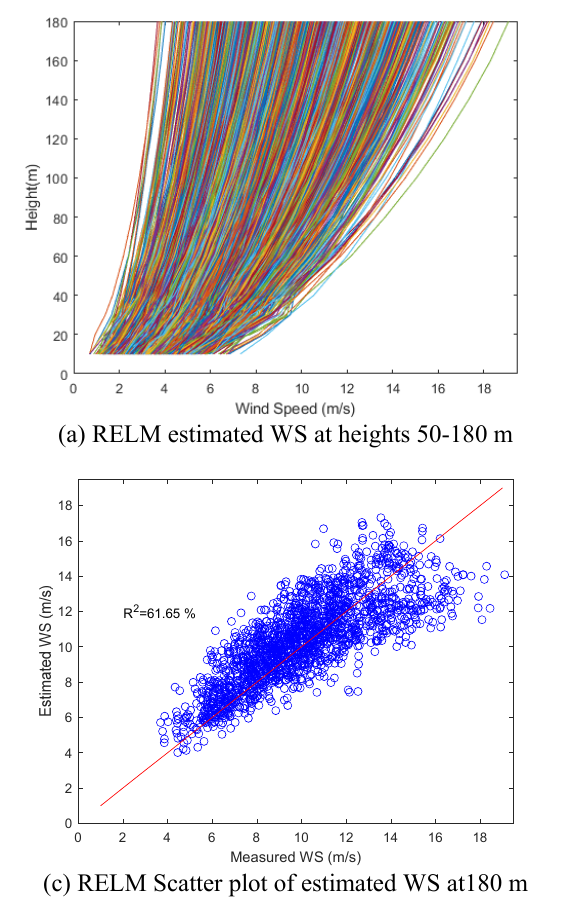
(f) Sample of measured and estimated WS at 100 m Figure 7. Results for estimation of WS at 100 m based on WS measurements at heights 10-40 m and estimated at 50-90 m.